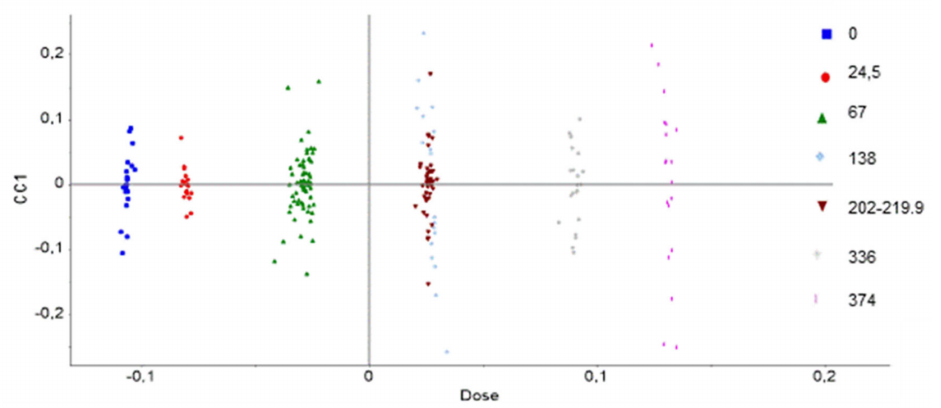
Figure 20. CC scores as a function of the UJV irradiation dose. In this analysis, the UJV irradiation doses are presented as follows: 1: 0 kGy, 2: 25 kGy (low dose rate), 3: 67 kGy (low, medium, and high dose rates), 4: 138 kGy (low dose rate), 5: 202 and 220 kGy (high and medium dose rates), 6: 336 kGy (high dose rate), 7: 374 kGy (medium dose